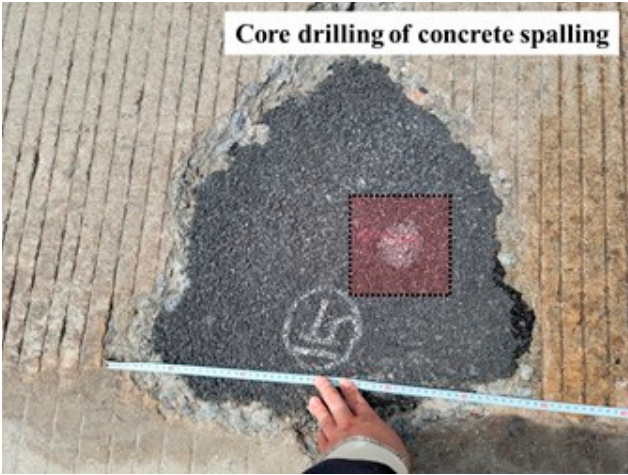
Figure 1. Core drilling position of concrete pavement slab around spalling. Table 2. Information of core specimens of the concrete pavement